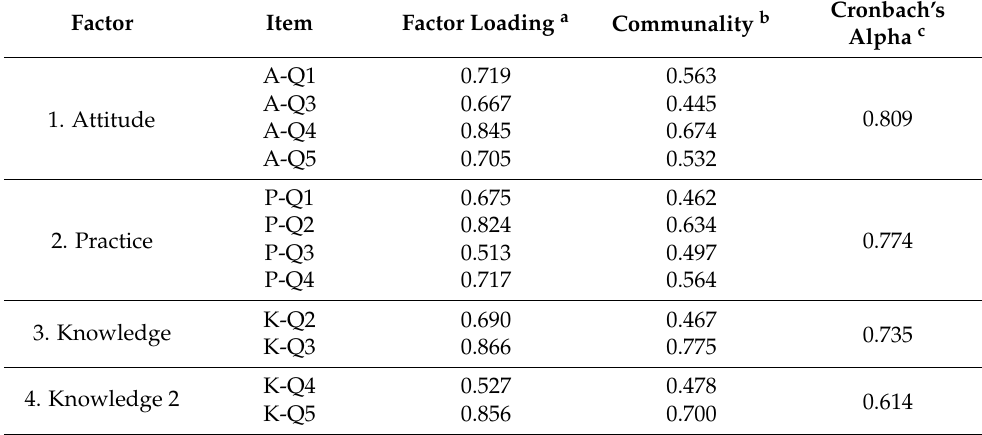
Table 6. Construct validity and